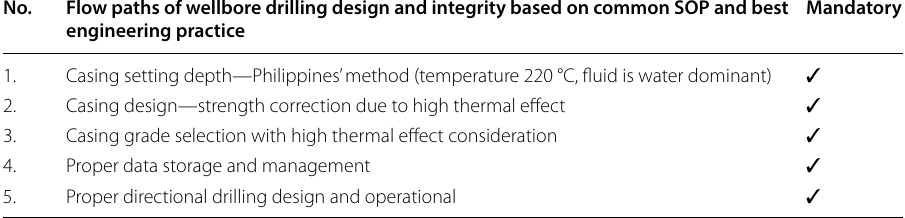
Table 5 Mandatory aspects in designing geothermal well in Field Dieng